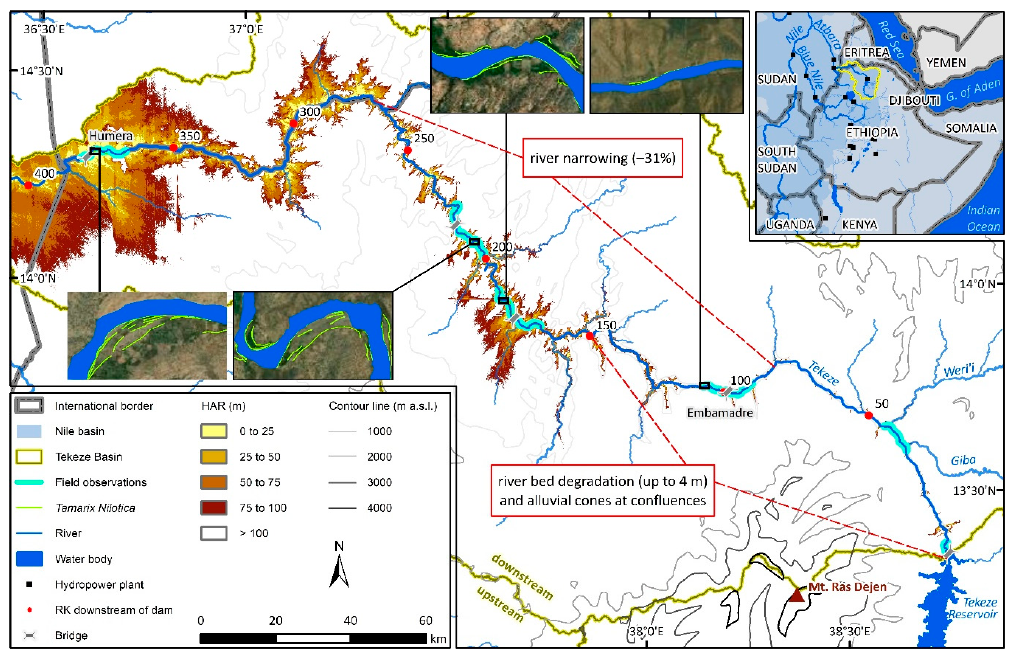
Figure 1. Location of the study area and representation of some of the main results (with RK = River Kilometer, HAR = Height Above the River within the Tekeze Basin and m ASL = meter above sea